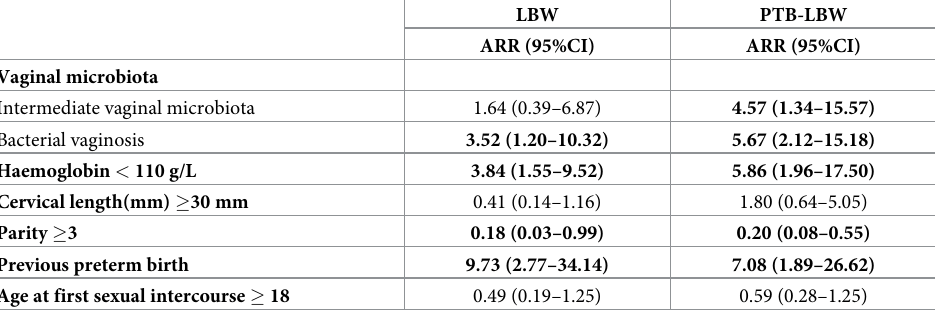
Table 5. Multivariate model for the association between bacterial vaginosis (risk factor) with low birth weight or low birth weight for preterm birth.